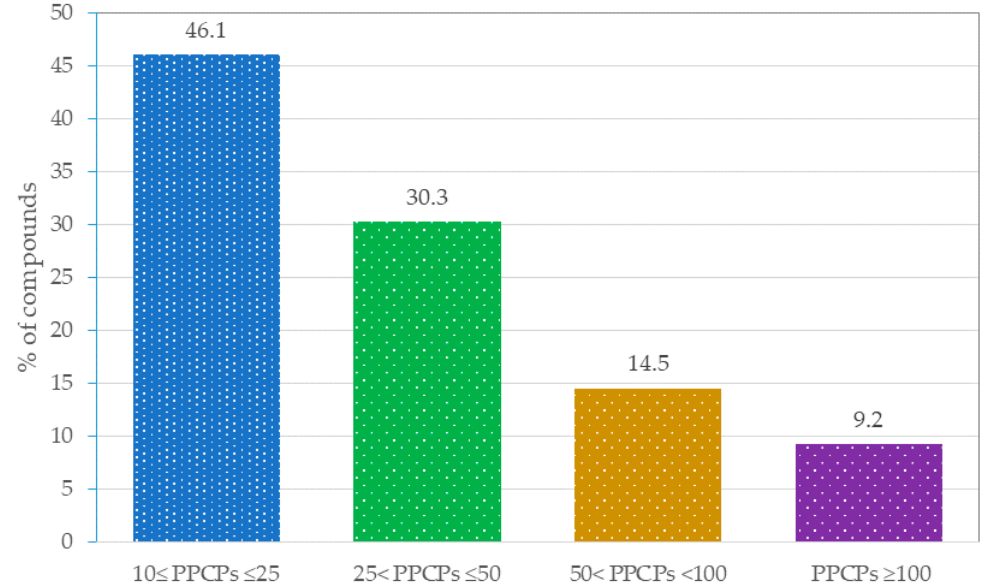
Figure 5. Percentage of studies according to the number of PPCPs analyzed.